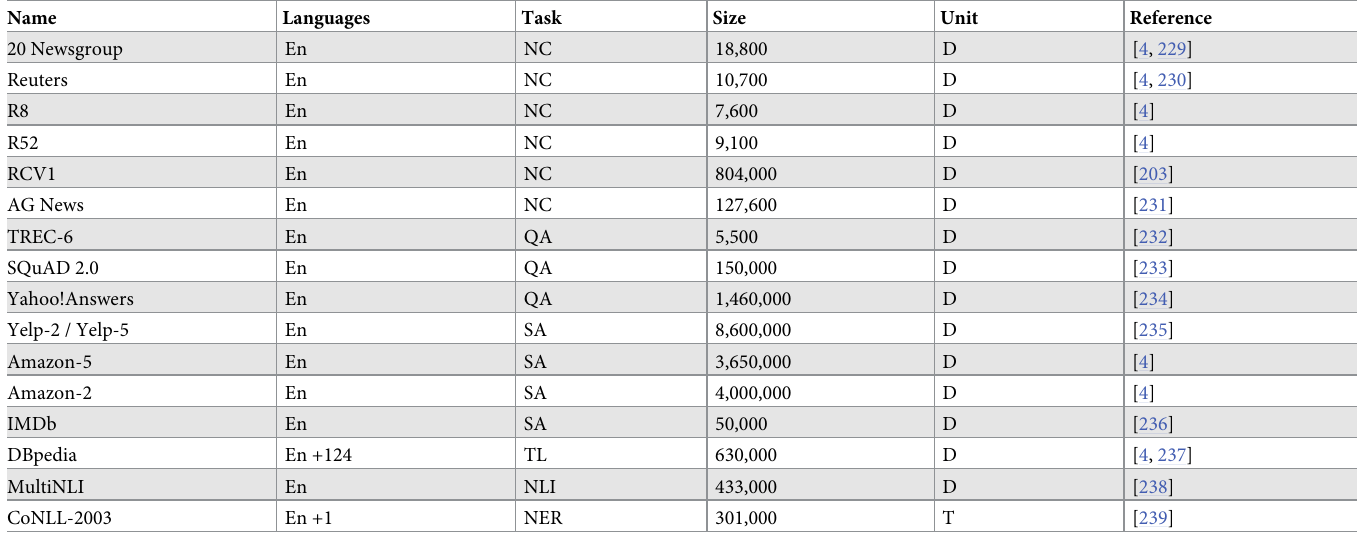
Table 7. English